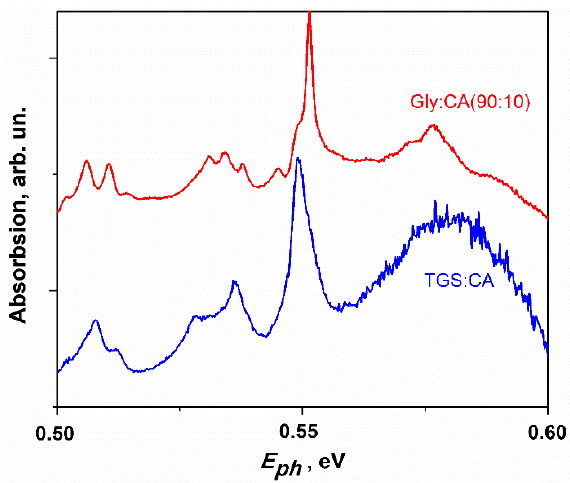
Figure 6. FTIR absorption spectra in spectral region E ph = 0.5–0.6 eV in Gly:CA (90:10) measured in this work and in previously studied TGS:CA (90:10) (see text).